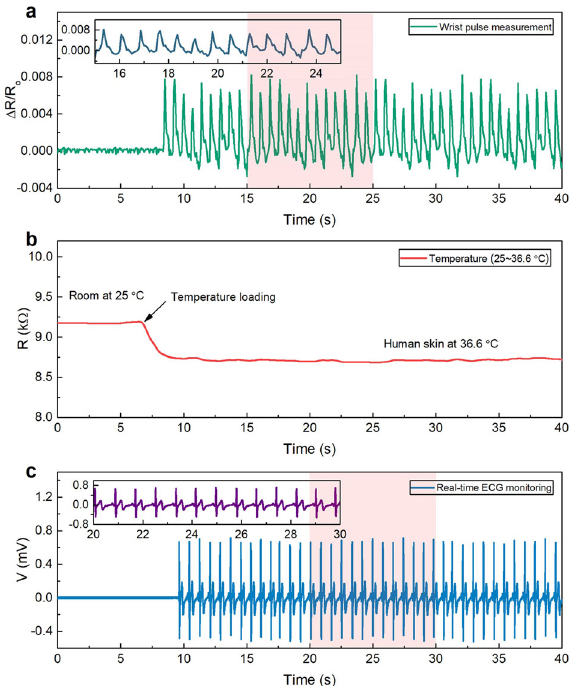
Fig. 6 Real-time detection. ( a ) subtle strain (i. e., wrist pulse), ( b ) skin temperature, and ( c ) ECG to validate the multifunctional ability of the proposed sensor. The sensor responds to the human wrist pulse and body temperature immediately after af fi xing it to the human wrist and later responds to ECG when touched by the right- hand fi